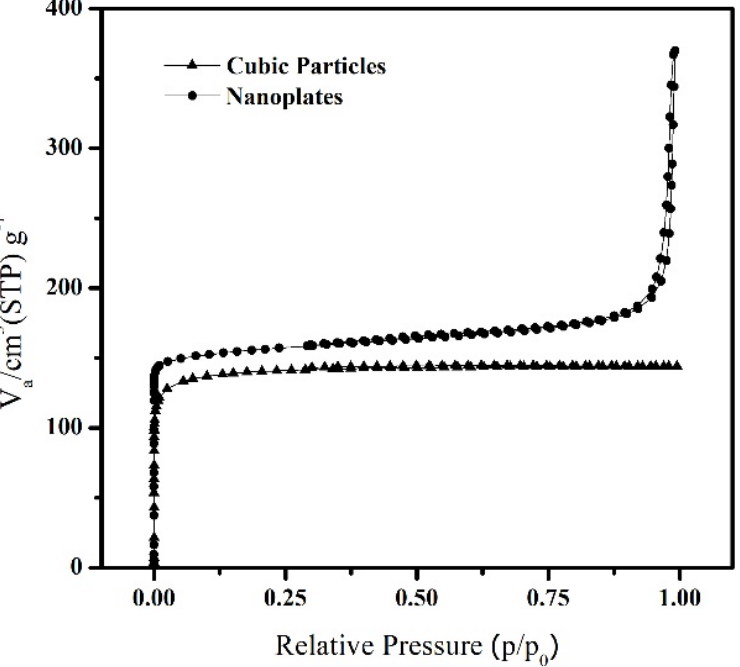
Figure 7. The effect of phosphoric acid addition time on the Si/Al ratio, P/Al ratio, and Si incorpora- tion of synthesized SAPO-34 particles.